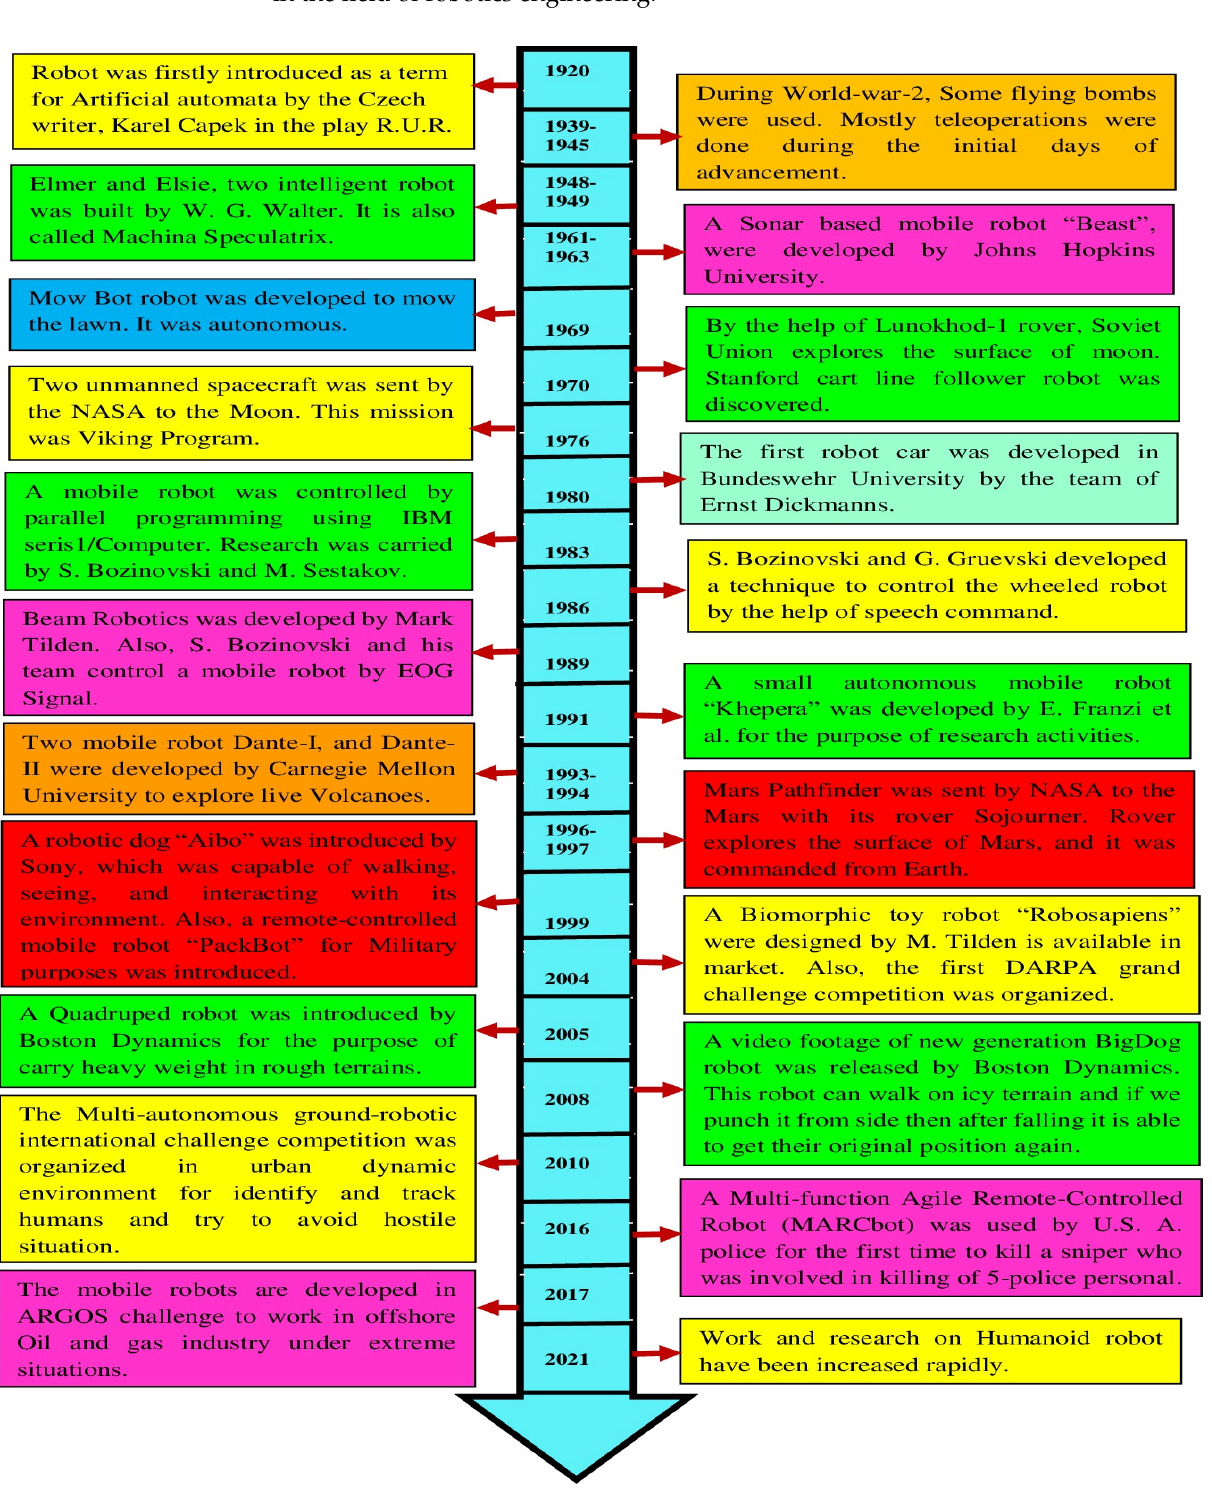
Figure 6. Some important and major events in the field of robotics science in the last 100 years (sources: Google search engine).